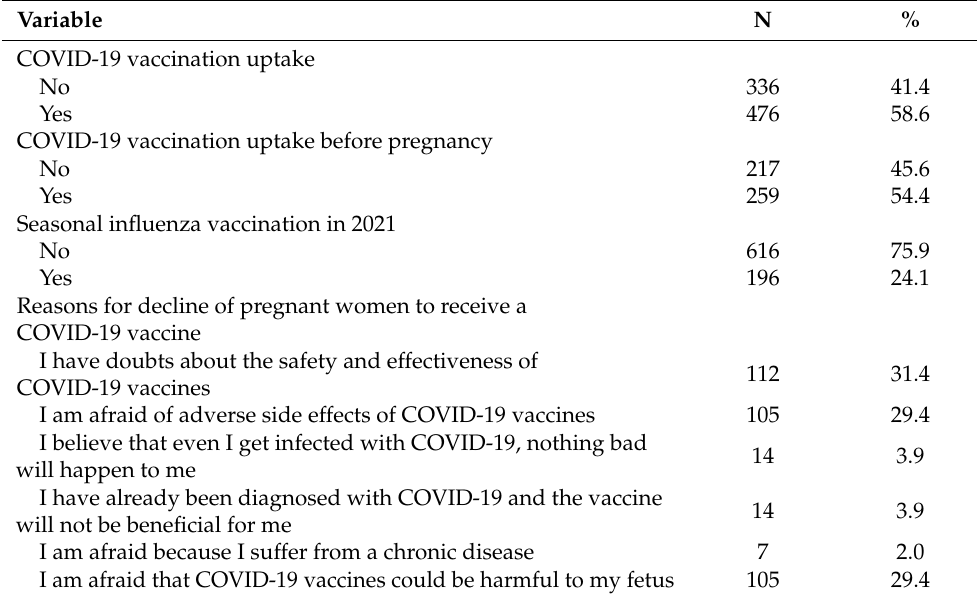
Table 2. COVID-19-related vaccination status in the pregnant women.